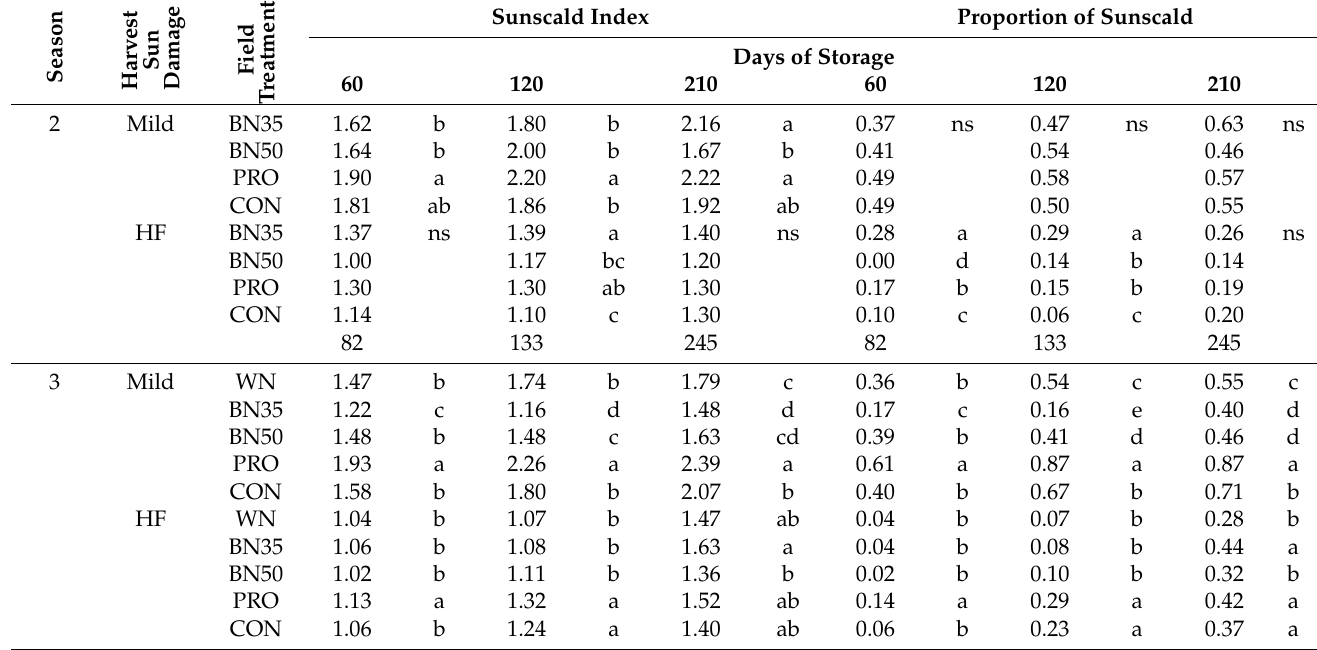
Table 3. Sunscald index (1 to 4) and proportion of sunscald according to season, sun damage condition at harvest (HF = healthy fruit, Mild = slightly sunburned fruit), field treatments (BN35 = Black net 35, BN50 = Black net 50, WN = White net, CON = control and PRO = protectants), and days of